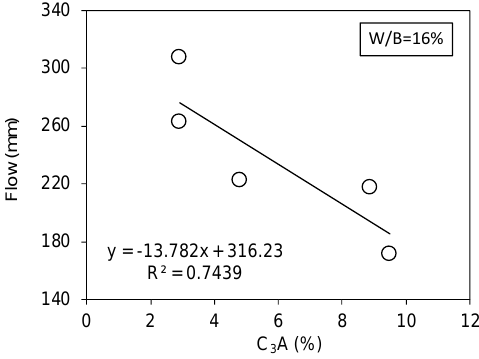
Figure 4. Relation between C 3 A content and flow.